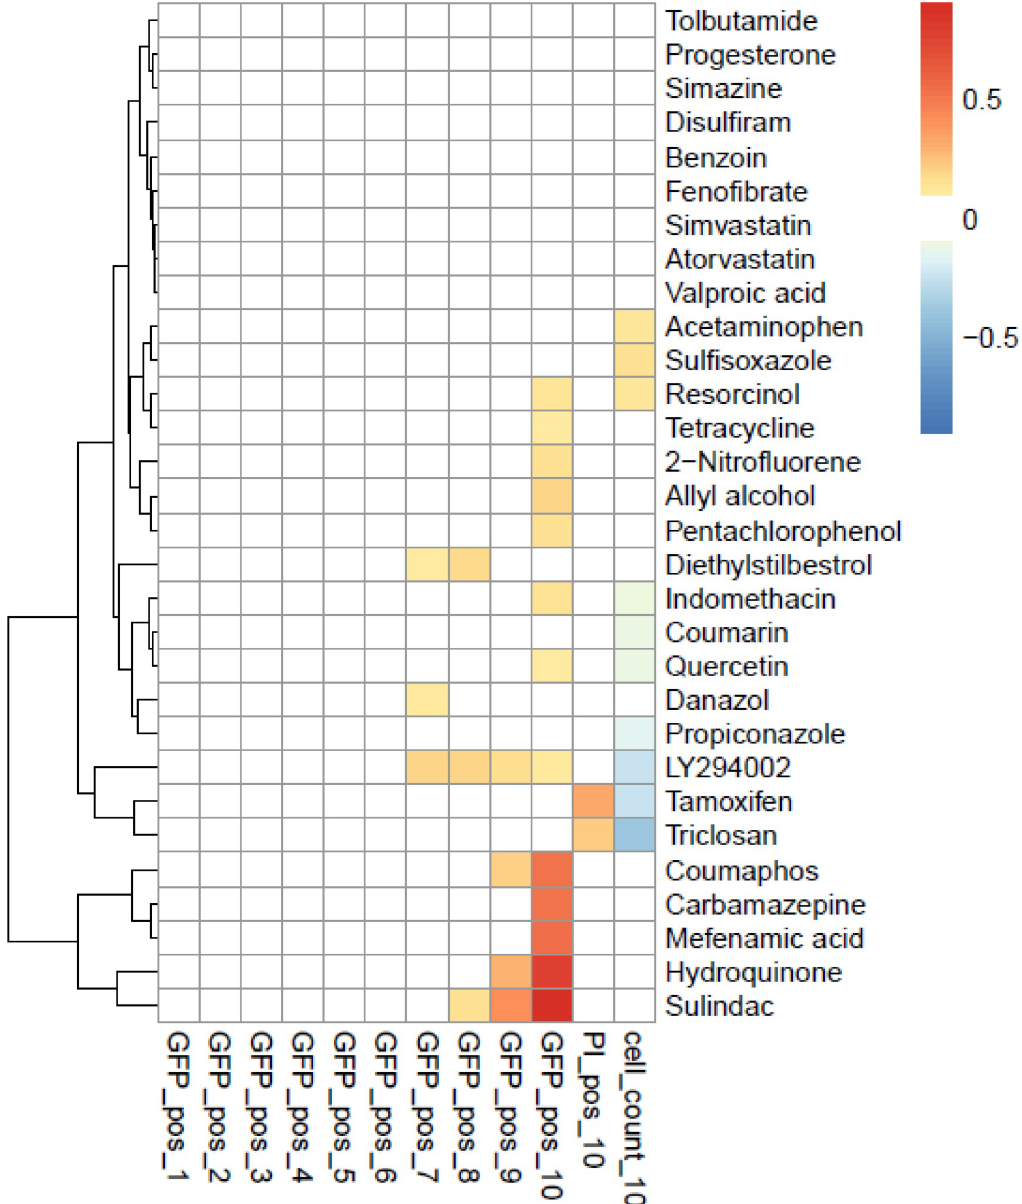
Fig 7. NRF2 activity of selected chemicals in HepG2 cells. Thirty chemicals tested for confirmation in the SRXN1-GFP assay. Cells were treated at multiple concentrations and examined for GFP accumulation over a 24-h period (GFP_pos_1–10) for concentrations 1 to 10. The last two columns, PI_pos_10 and cell_count_10, are the Propidium Iodide positive fraction of cells (marker for necrosis/ dead cells) and cell count compared to the negative control,